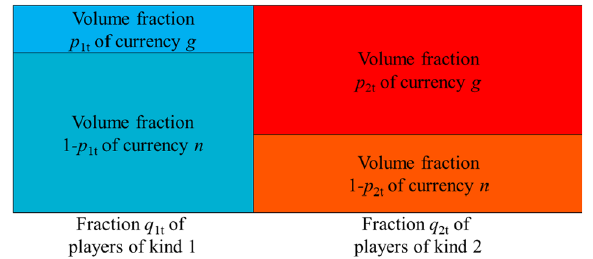
Fig. 1 Volume fractions p 1t and p 2t of transactions in currencies g and n for two kinds of players of different fractions q 1t and q 2t . Player i , i ¼ 1 ;